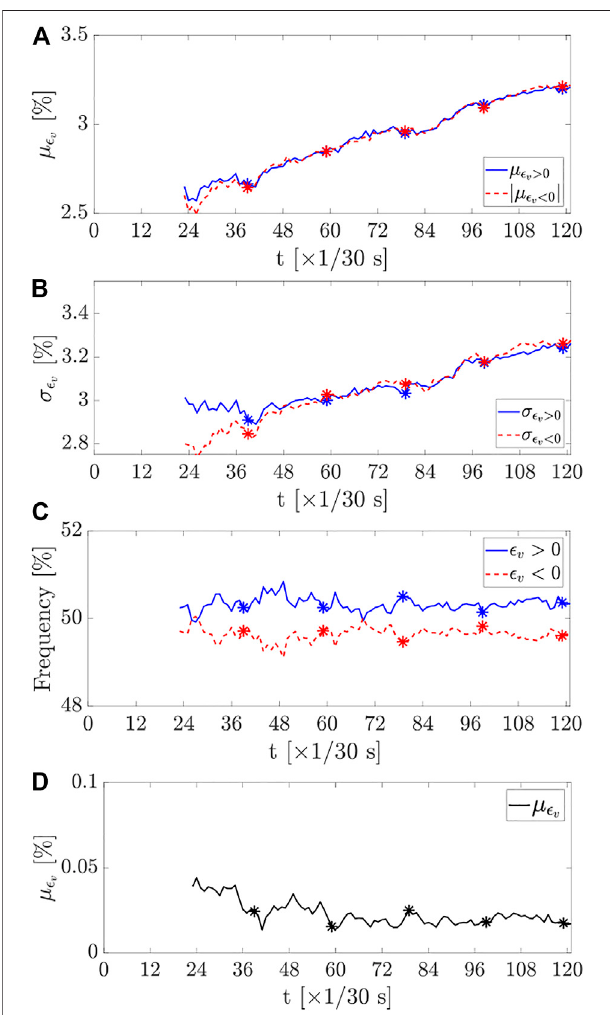
FIGURE 9 | Time evolution of mean, standard deviation, and frequency ofpositiveandnegativevolumetricstrainscapturedinsidethe fi nger (A,B) and (C) , respectively, and mean of volumetric strains inside the fi nger (D) for test (1). The time instants corresponding to the images of test (1) in Figure 7 are labeled bythesymbol*.The reference t 0 corresponds totheinstantofgas entering the sample.